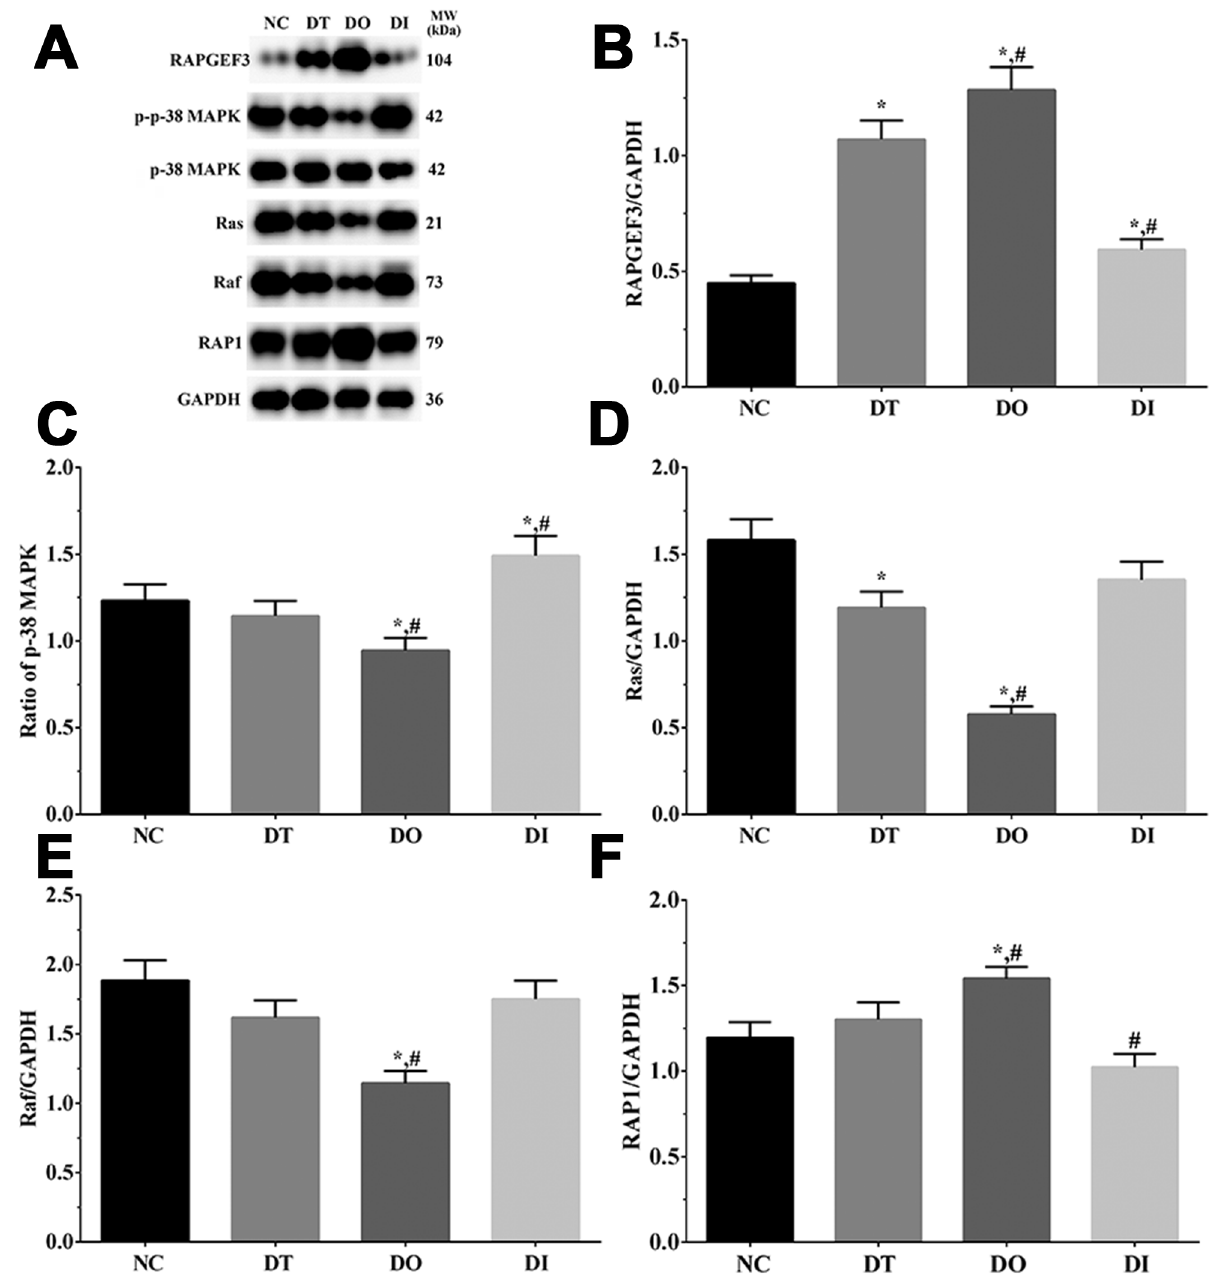
Figure 7 – Activation of Ras/Raf/MAPK in glial cells. (A) Western blotting analysis of RAPGEF3, p-38 MAPK, Ras, Raf and PKC in glial cells. (B-F) Quantitative analysis of each target protein. Data was presented as mean ± SD, each experiment was repeated for three times. *P<0.05 vs NC group of cells. #P<0.05 vs signal dezocine treatment group. NC: normal group, DT: dezocine treatment group, DO: dezocine treatment combined with RAPGEF3 overexpression group, DI: dezocine treatment combined with RAPGEF3 inhibition group. SH: sham group, TD: dezocine treatment group, TO: dezocine treatment combined with RAPGEF3 overexpression group, TI: dezocine treatment combined with RAPGEF3 inhibition